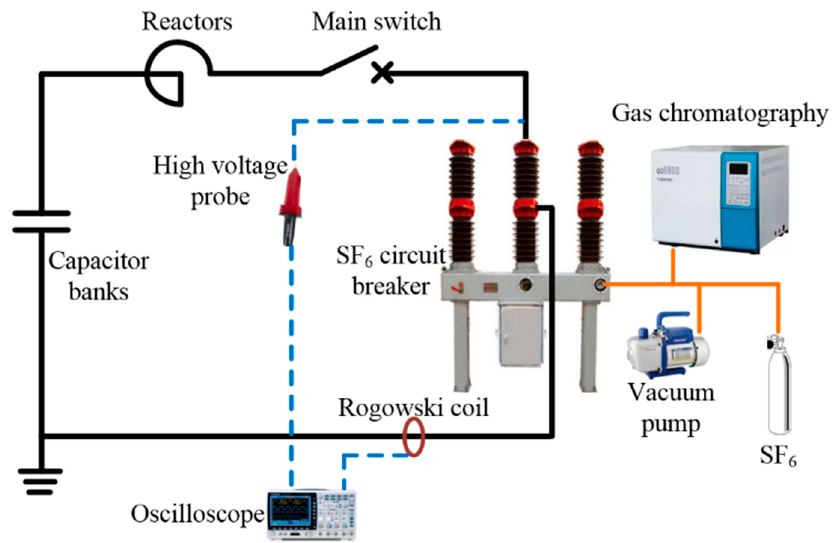
Figure 1. Schematic of experimental arrangement.